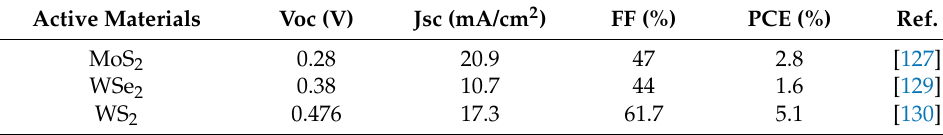
Table 1. Summarized device performance of solar cells in Section